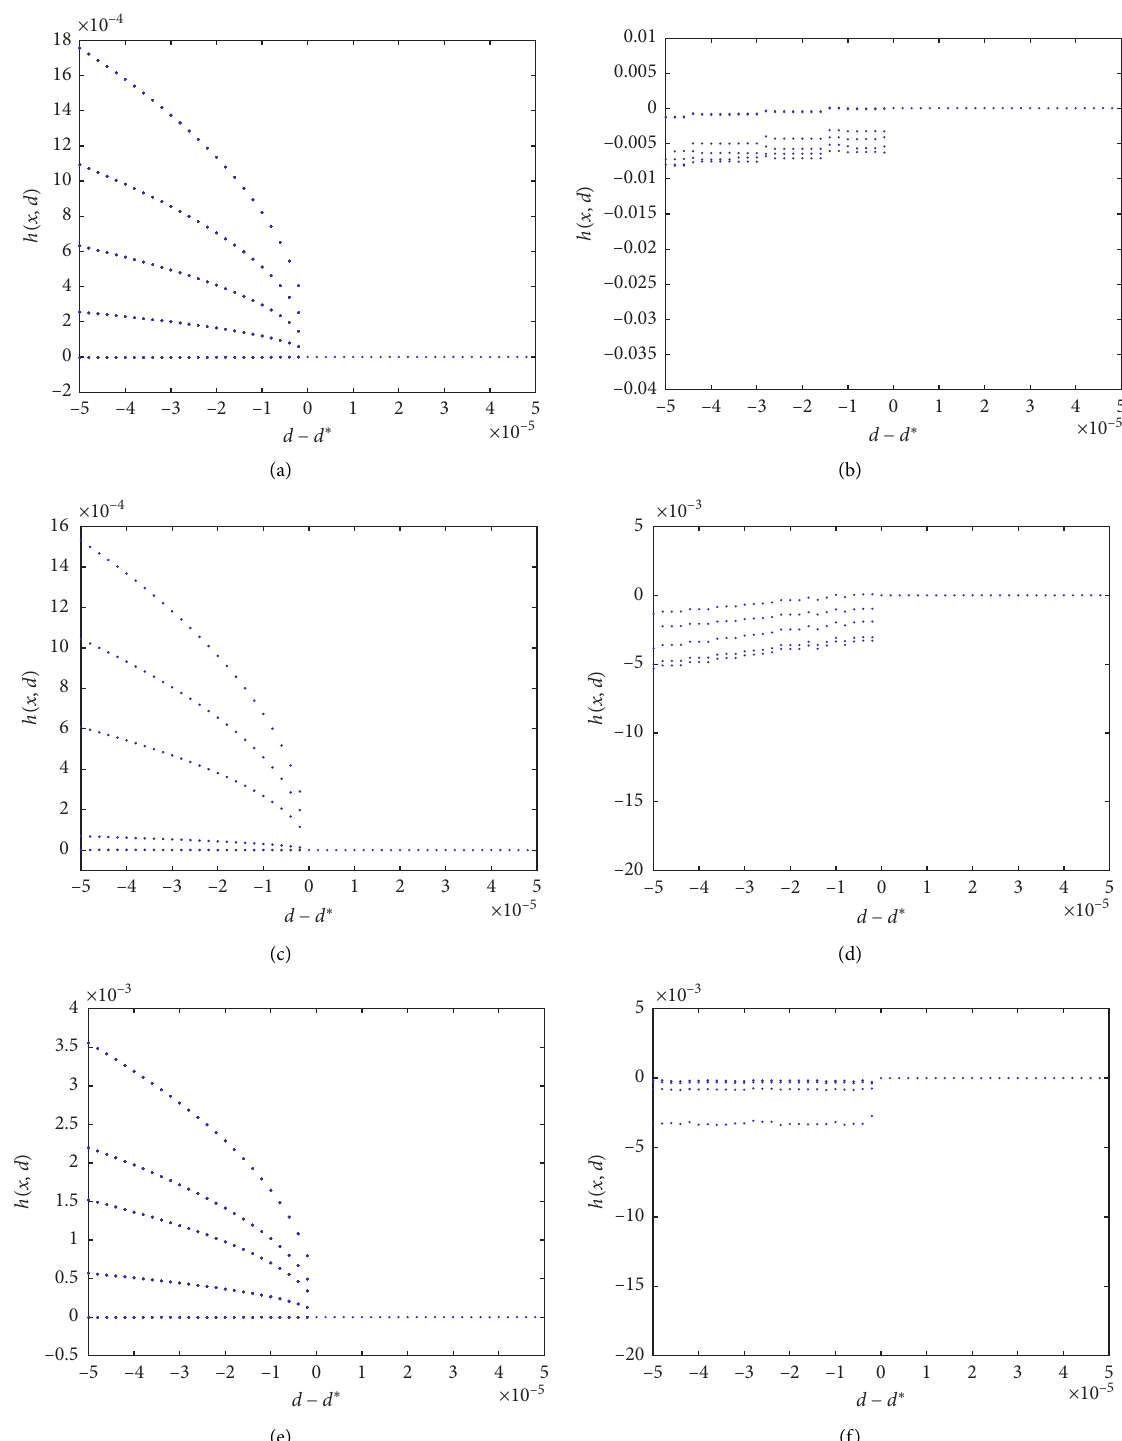
Figure 4: Bifurcation diagram of a stable grazing bifurcation after control. (a) ( 1/1 ) impact periodic motions based on the numerical simulation obtained by the discontinuity maps (38) and (39). (b) Direct numerical simulation on Poincar´e section Π periodic motions. (c) ( 1/2 ) impact periodic motions based on the numerical simulation obtained by the discontinuity maps (38) and (39). (d) Direct numerical simulation on Poincar´e section Π of ( 1/2 ) impact periodic motions. (e) The codimension-two grazing bifurcation points 2 based on the numerical simulation obtained by the discontinuity maps (38) and (39). (f) Direct numerical simulation on Poincar´e section Π of the codimension-two grazing bifurcation